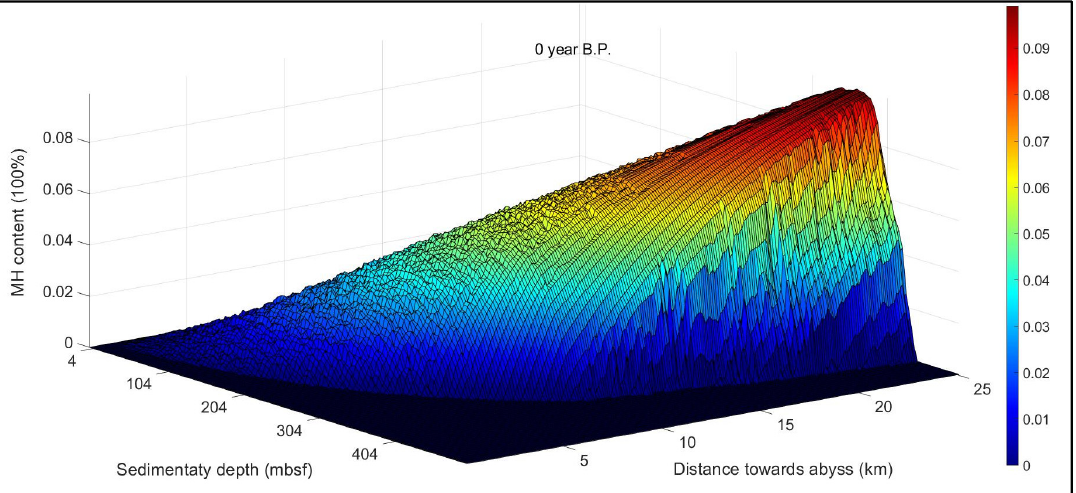
Figure 10. Peak irregularity of MH content distribution along Dongsha continental slope area.